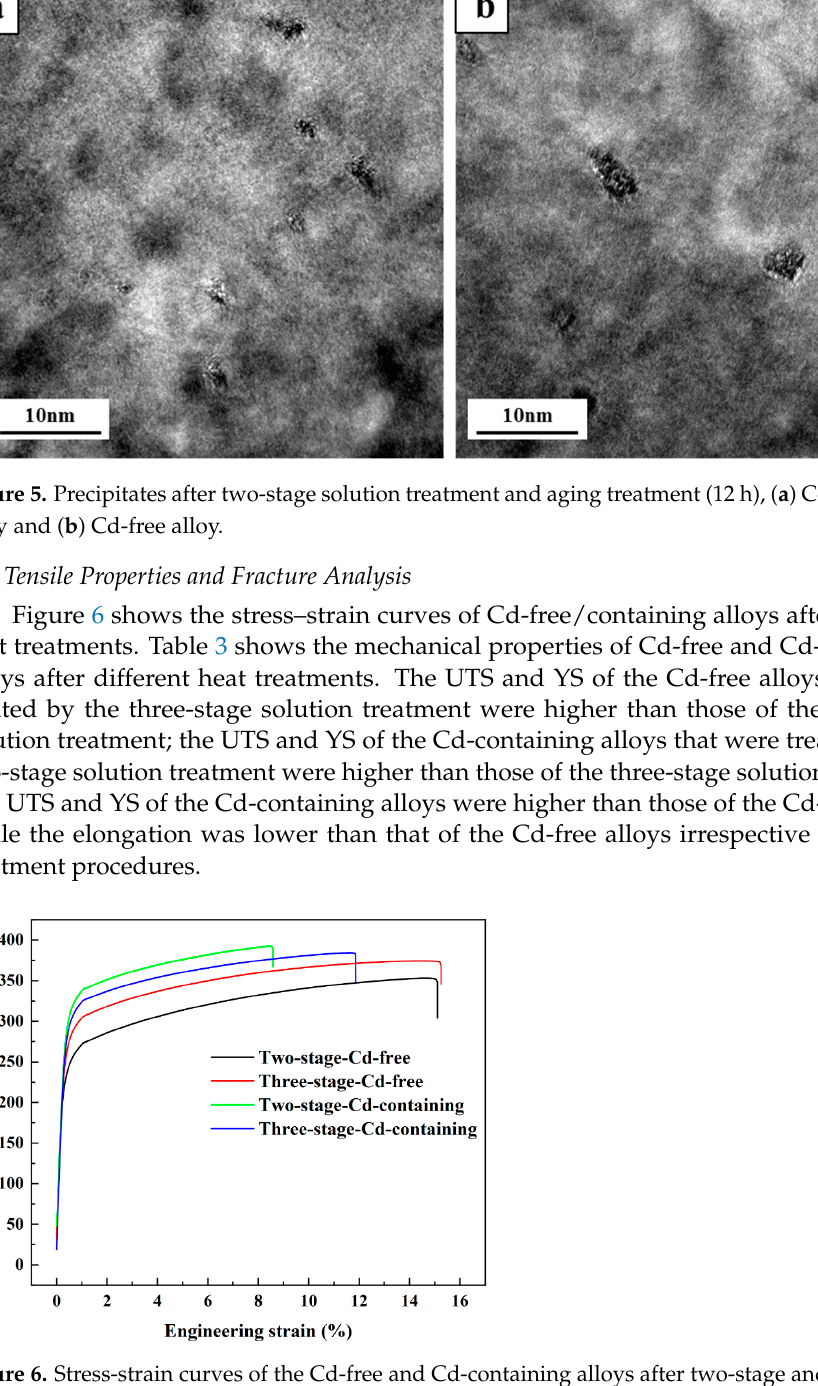
Figure 6. Stress-strain curves of the Cd-free and Cd-containing alloys after two-stage and three-stage heat treatment. Table 3. Mechanical properties of the Cd-free and Cd-containing alloys after T6 heat treatment.